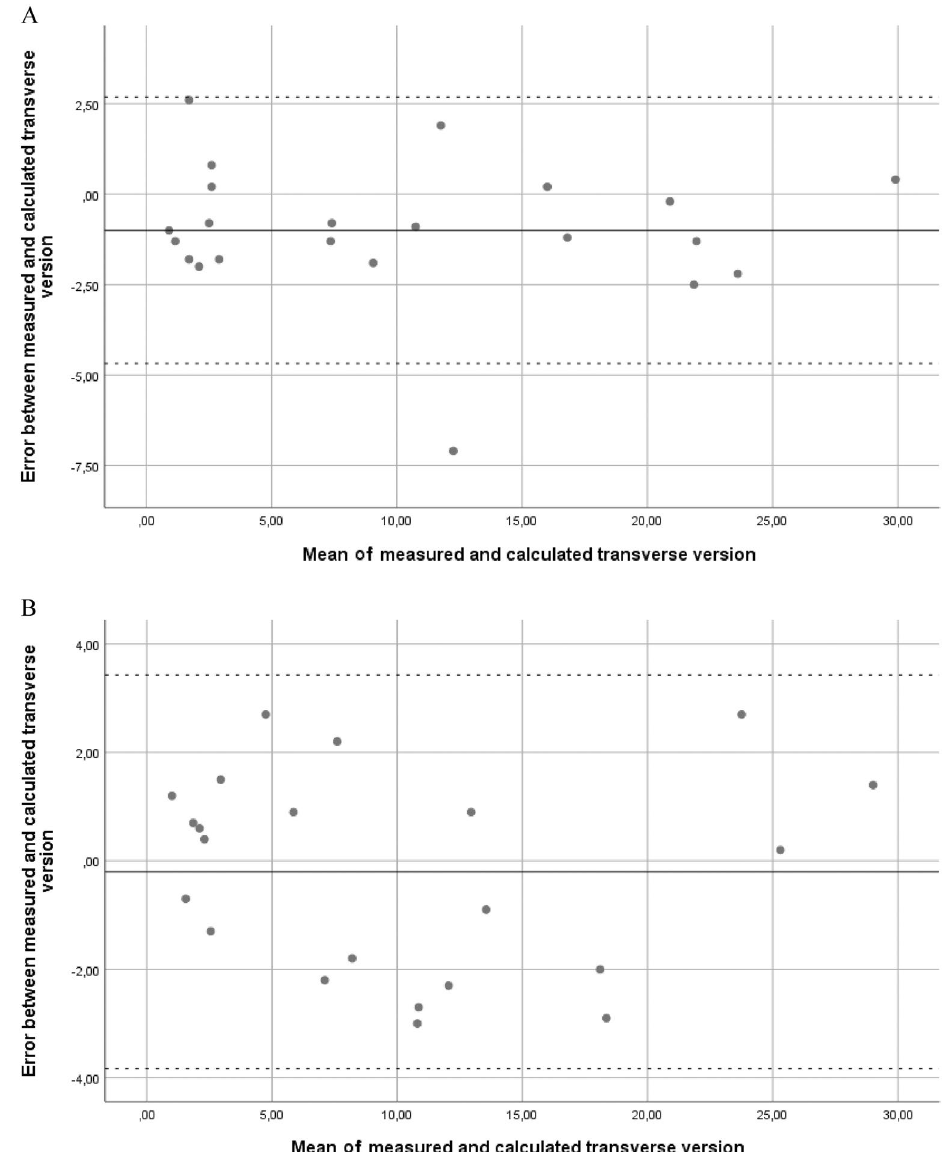
uncorrected for mechanical angle. ( B ) Transverse version corrected for mechanical angle.